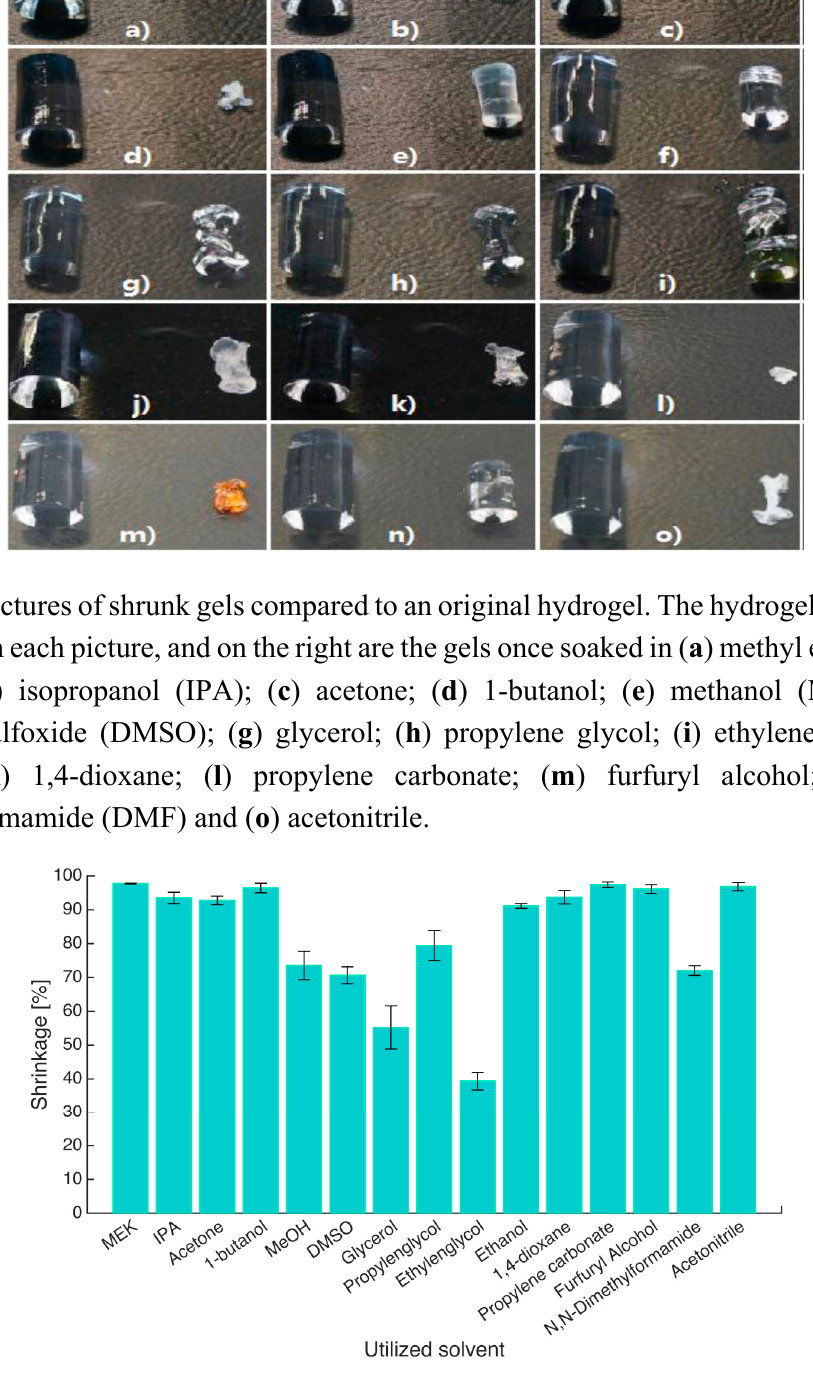
Figure 2. Volumetric shrinkage (S 1 ) of gels in different solvents after one step solvent exchange. The horizontal labels are the names of solvents, in which hydrogels were immersed. Error bars represent standard deviation of three parallel